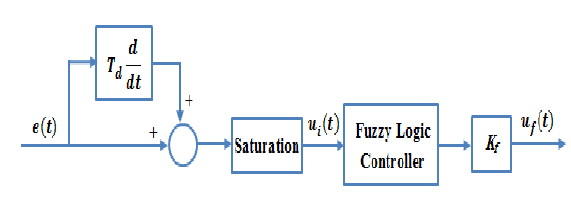
Fig. 5. Fuzzy PD logic